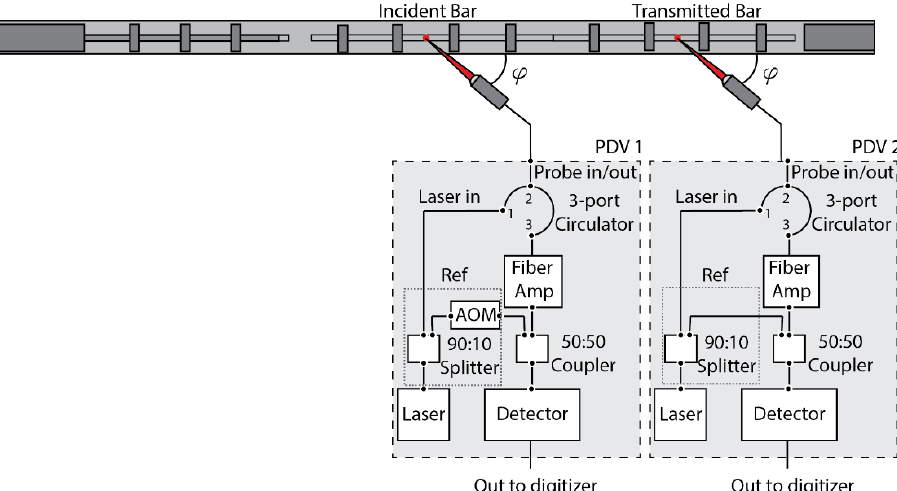
Figure 2. The placement of the probes and schematic of the present PDV setup. The components of the PDV are boxed by a dashed line, and the components of the reference leg is boxed by a dotted line. The reference leg may or may not be frequency modulated. PDV 1 and 2 show a reference leg with and without an acousto-optic modulator (AOM), respectively.